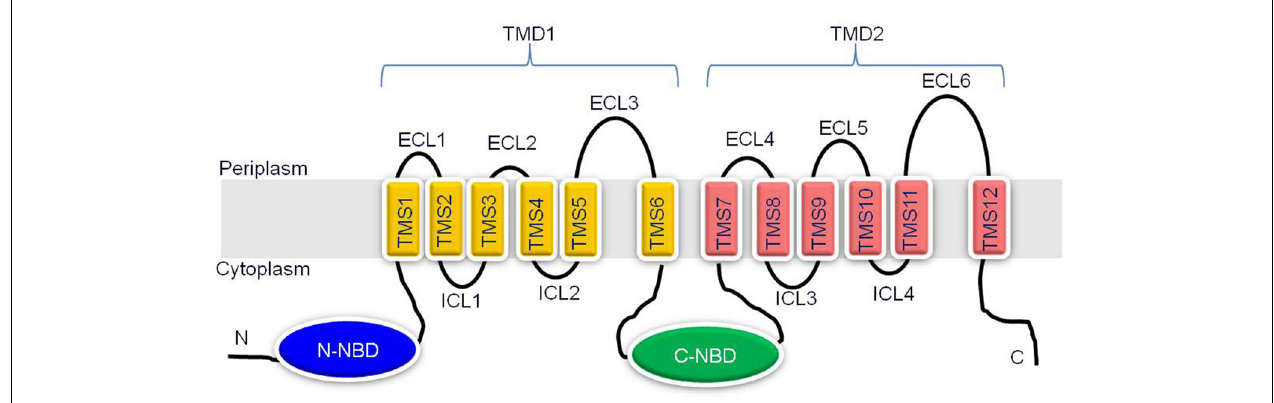
FIGURE 2 | Schematic representation of the predicted topology of Cdr1p. Cdr1p is predicted to have two transmembrane domains (TMD1 and TMD2) and two NBDs, (N- and C-terminal NBDs) organized in reverse (NBD-TMS6) 2 topology. The amino and carboxyl